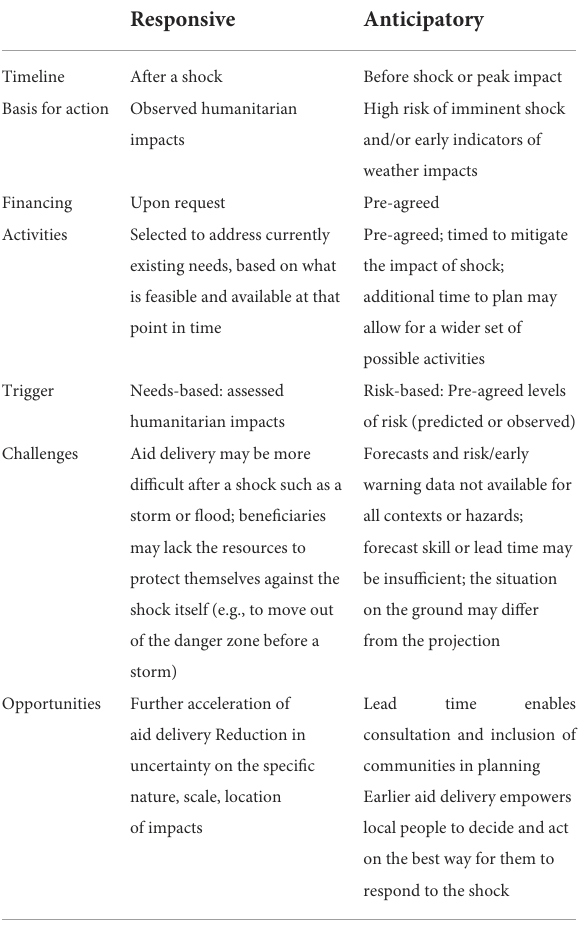
TABLE 1 Comparison of humanitarian action types.